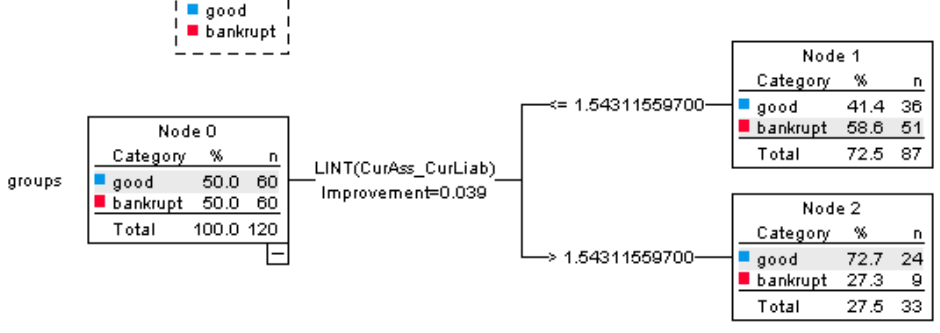
Figure 4. Decision tree view for testing sample, period: 1 year before bankruptcy.